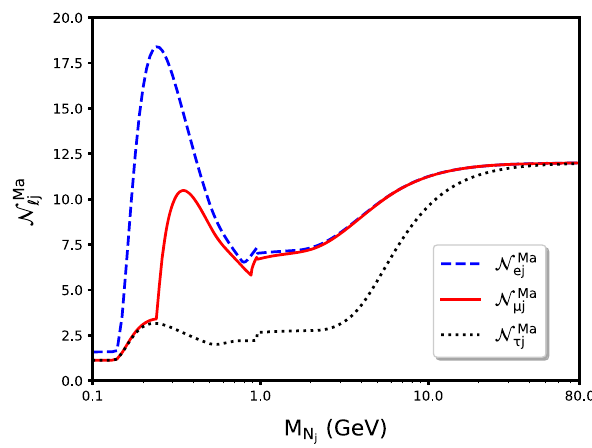
Fig. 2 Effective mixing coefficients N Ma (cid:2)